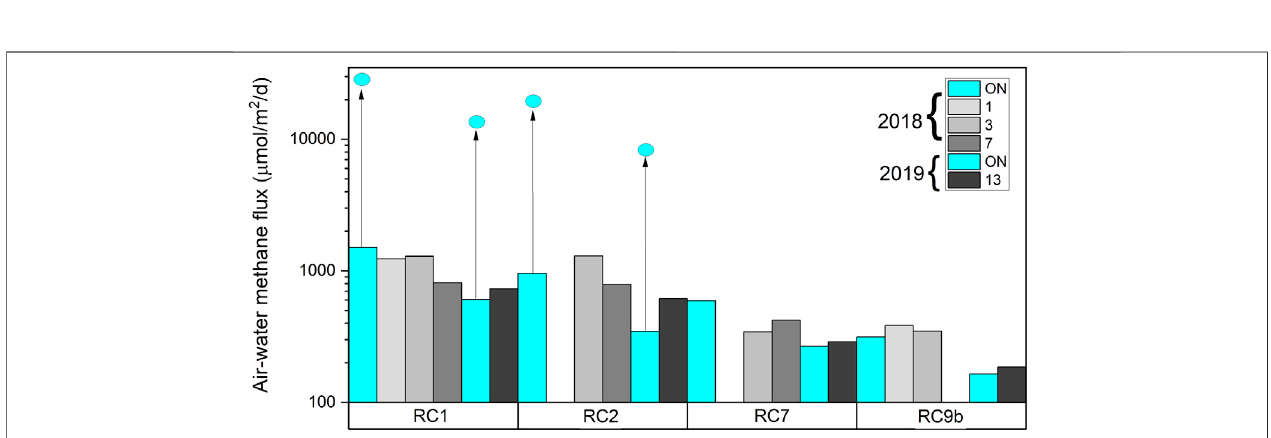
FIGURE8| Air-watermethane fl uxfor2018and2019.Aeratedwatersareinblue,andnon-aeratedwatersareshowningrayscalethatcorrespondstothenumber of days aerators were off. The bars indicate the fl ux calculated with the stagnant boundary layer model, whereas the extended arrows to the blue dots indicate the fl ux recalculated with bubble in fl